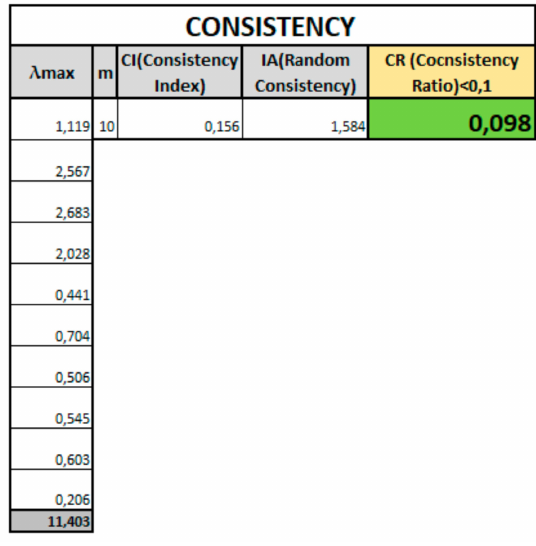
Figure 5. Example of consistency of the